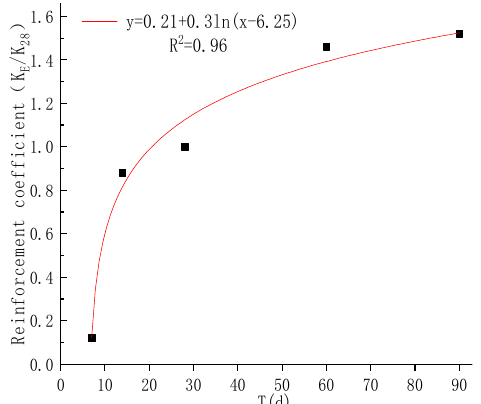
which shows a good correlation. Therefore, it is feasible to use equation (4) to predict the strength of Figure 9. Relationship between KE/K28 and curing time. Figure 9. Relationship between KE/K28 and curing time. DGSC-solidified soil.